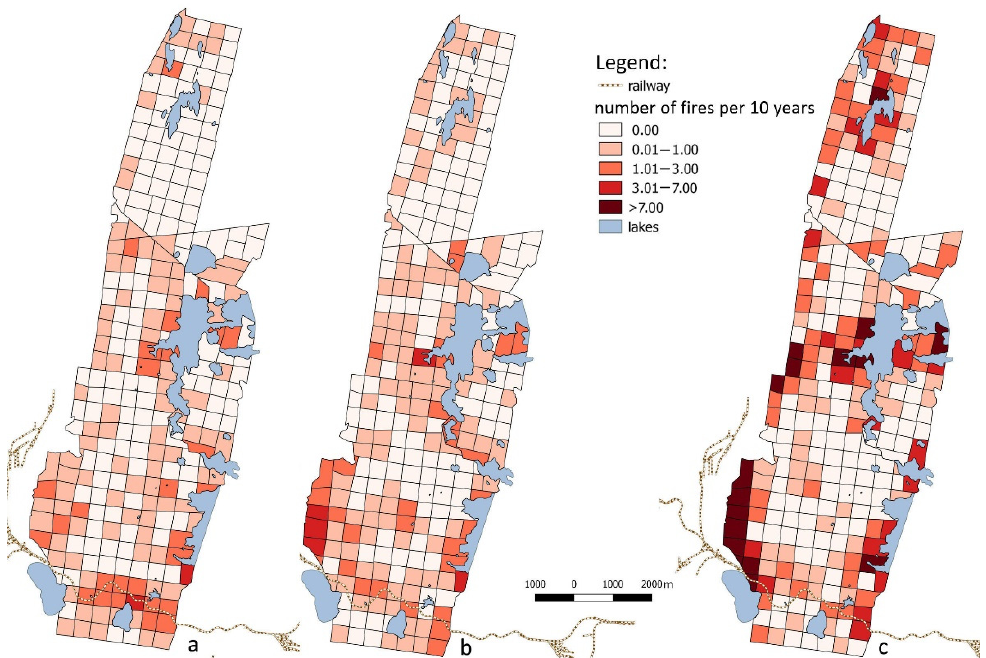
Figure 5. The spatial distribution of the number of fires per compartment per 10 years in ( a ) 1948–1970, ( b ) 1971–1990, and ( c ) 1991–2014.